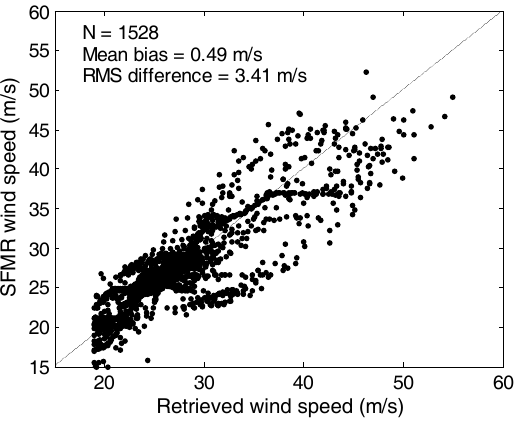
Figure 6. SFMR wind speed products versus the retrieved wind speeds using the AMSR-E 6 and 10 GHz brightness temperature data.